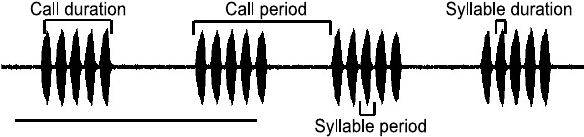
Figure 2. Oscillogram of Gryllusbimaculatus illustrating mea- sured temporal features. Scale bar represents 0.5 second.